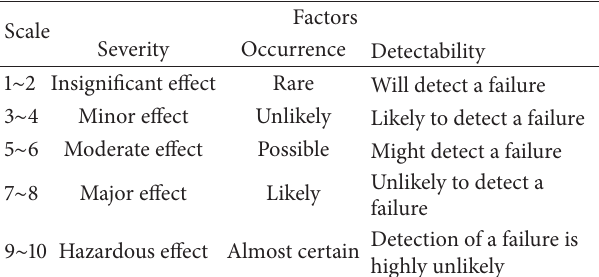
Table 1: Description of the three risk factor